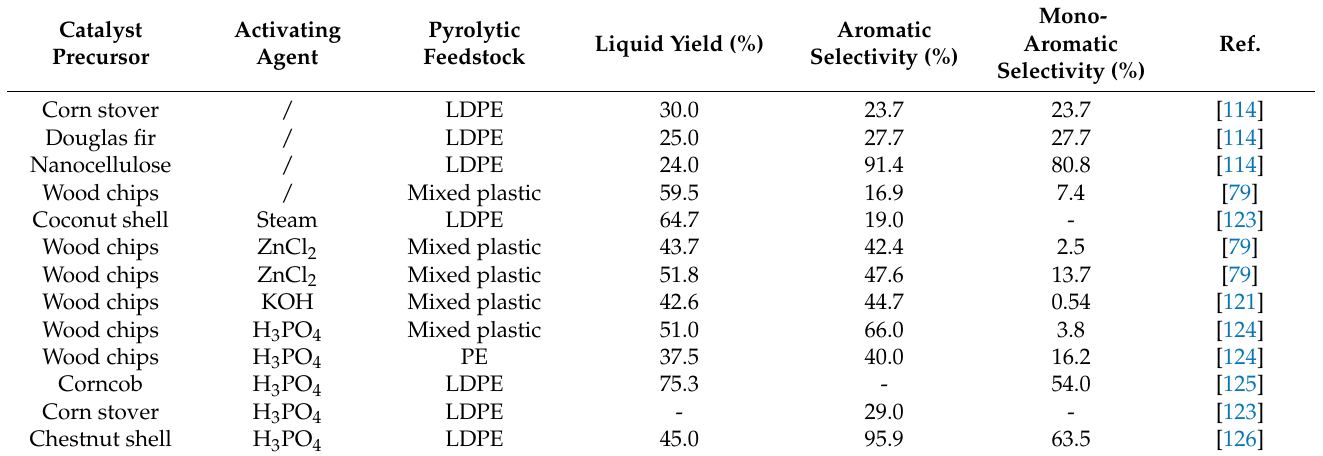
Table 4. Liquid yield and aromatic selectivity from catalytic pyrolysis of plastics with